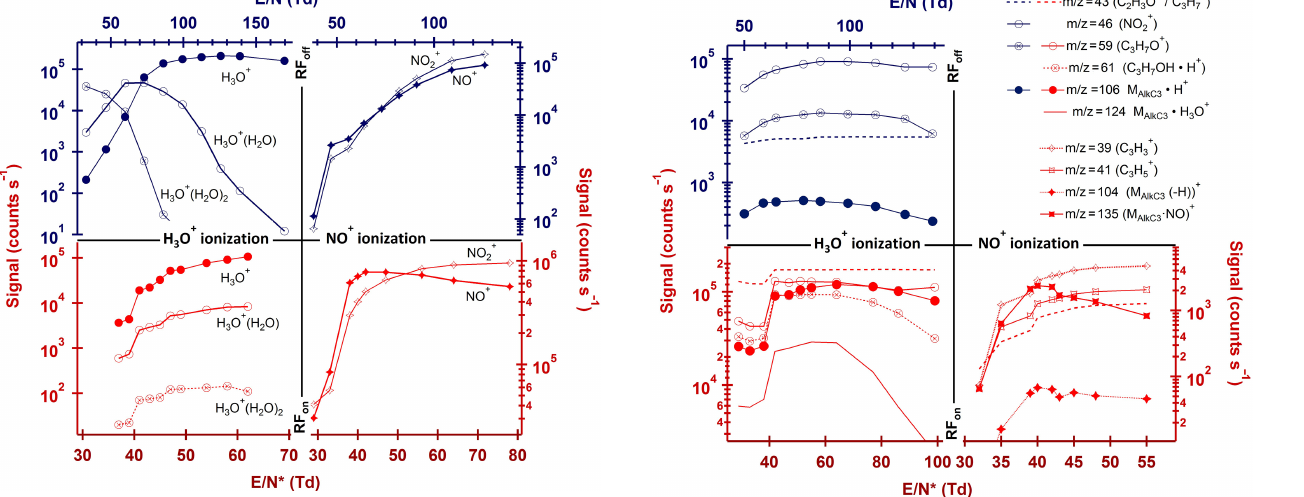
Figure 2. The E/N ratio influence over the AlkC3 identification for several representative signals in both ionization modes (H 3 O + , left; NO + , right) as recorded in absence (up)/presence (down) of a RF funnel. The common signal at m/z = 43 is equally plotted as a fragmentation mark (right